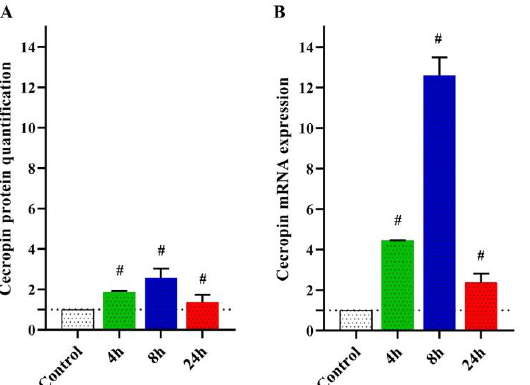
Figure 1. Md Cec expression of control and curcumin-injected M. domestica larval hemolymphs after 4, 8, and 24 h of injection. ( A ) Cecropin quantification analyzed by Nano LC – MS/MS. ( B ) Relative Md Cec-mRNA expression analyzed by qRT-PCR. Different letters indicate significant difference ( p < 0.05). Data were illustrated as mean ± SD, ( n =